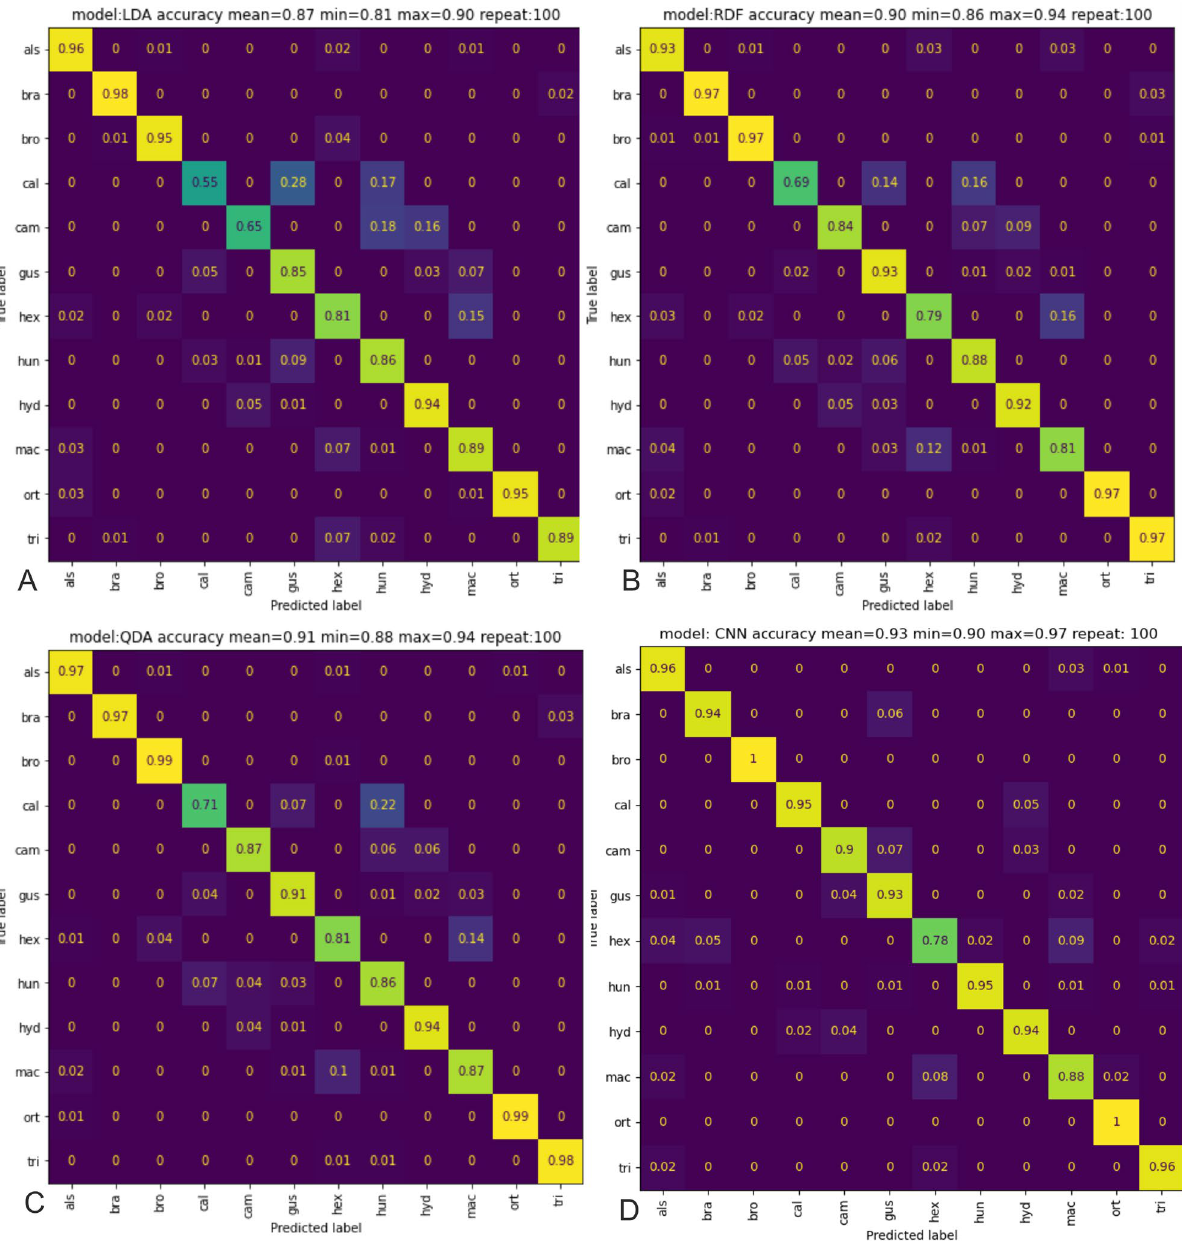
Figure 2. Confusion matrix in 100 repetitions in methods: ( A ) LDA; ( B ) RDF; ( C ) QDA; ( D ) CNN